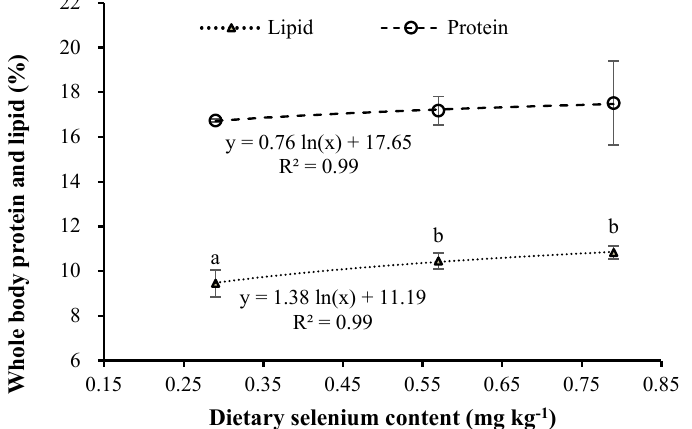
Figure 1. Relation between dietary Se levels and protein or lipid contents (% fresh weight) in whole body of gilthead seabream after 13 weeks of feeding diets with different supplementation of OH ‐ SeMet.